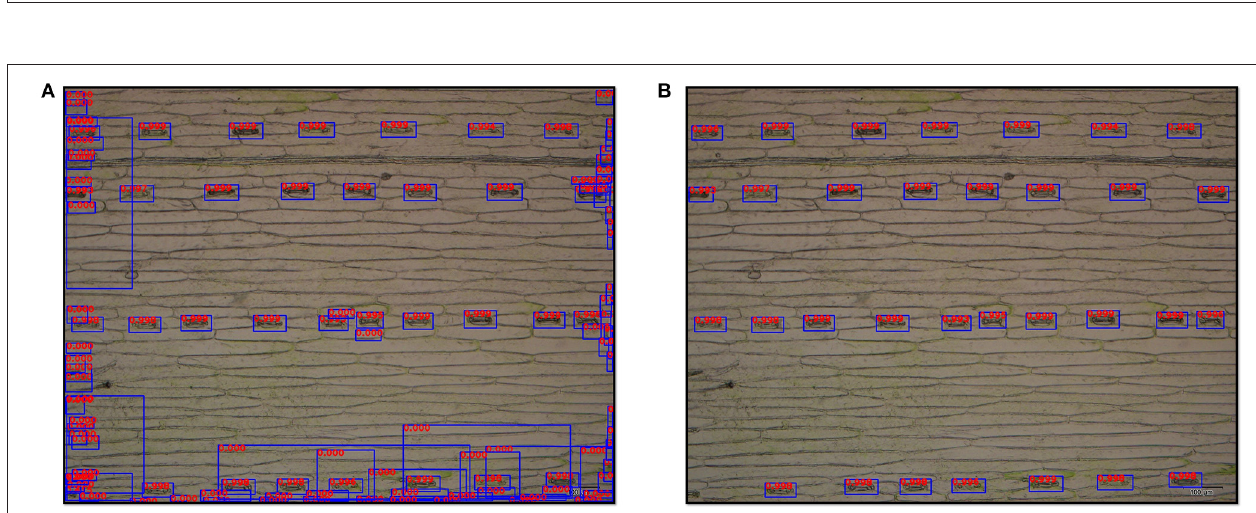
10 magnification. (A) Original detection result with all proposal ×